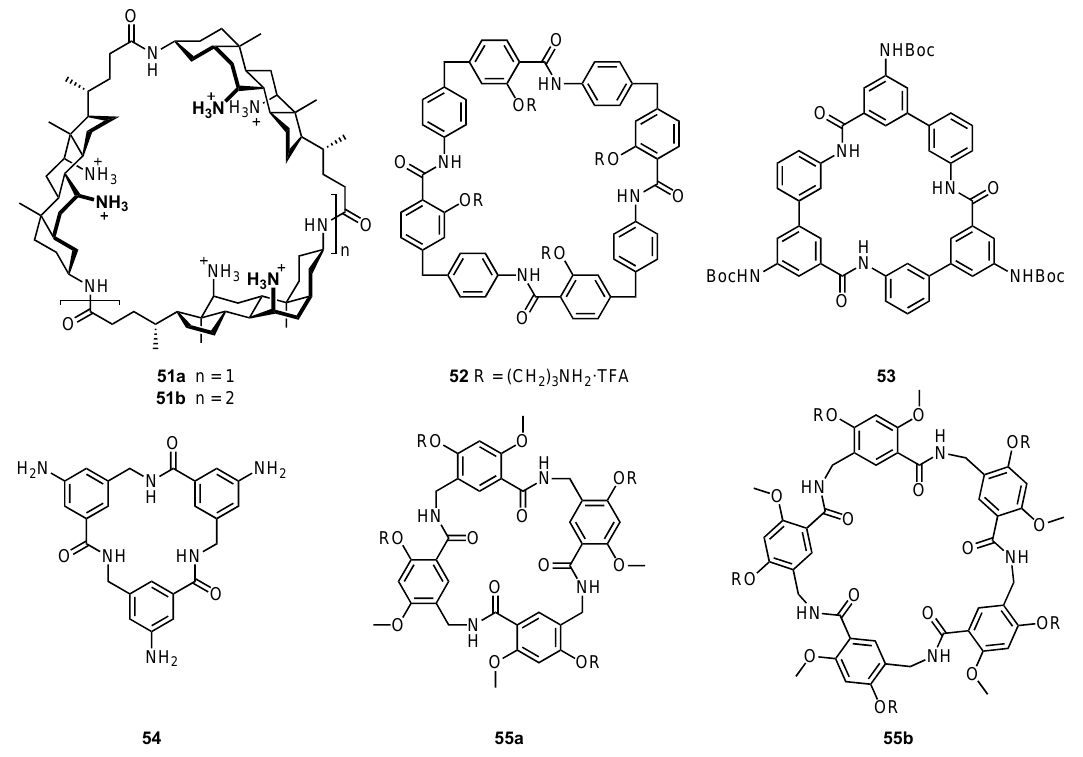
27 of 37 Figure 19. Structures and preferred calculated conformations of the furan-containing cyclopeptides 49a – d ( a ) and 50 ( b ). The structures of 49a and 50 were calculated by the author of this review based on the reported results by using Spartan 20 (Wavefunction, Inc., Irvine, CA, USA) and the MMFF force-field (see Supporting Information). The side chains of 50 are truncated and protons, except acidic ones, are omitted for reasons of clarity. Shifting the aminomethyl group from the 5-position in 49 to the 4-position in 50 also results in a tilted arrangement of the furan moieties (Figure 19b) [177]. The converging arrangement of the NH groups is retained, however, and 50 thus also interacts with